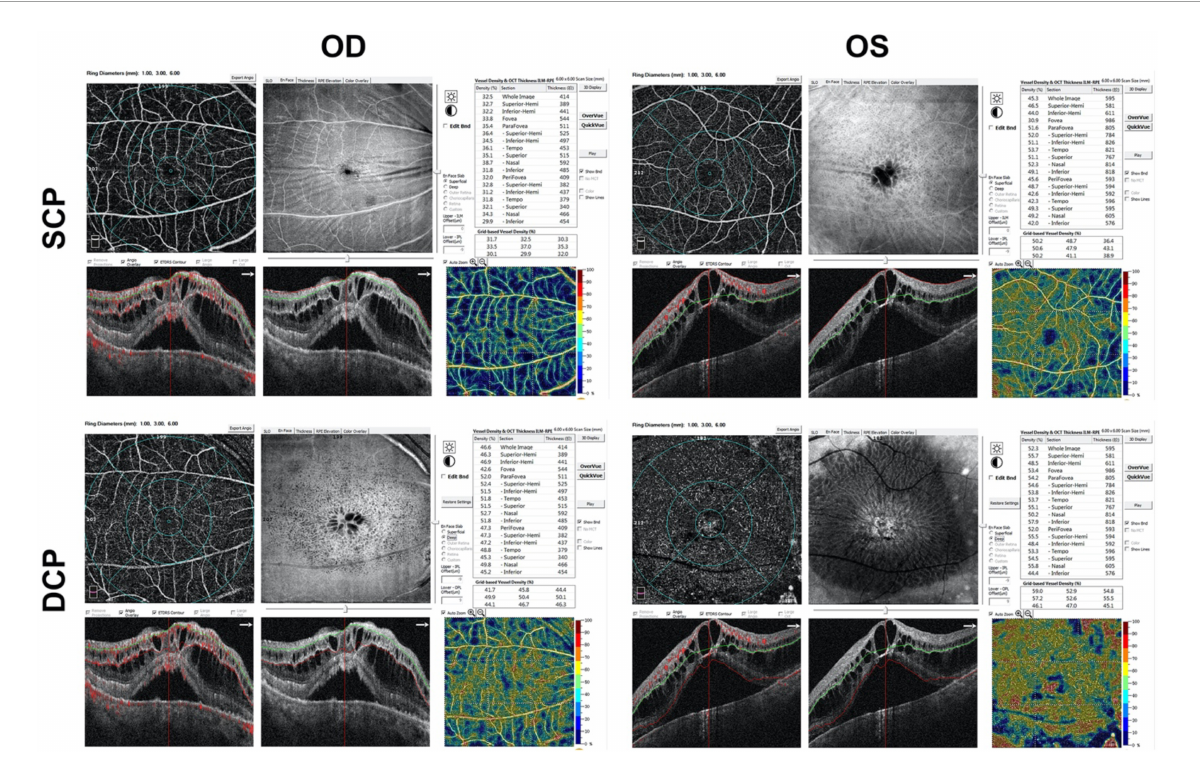
FIGURE3 Marked cystoid macular edema with intraretinal fluid, subfoveal neurosensory retinal detachment and pachychoroid on OCTA b-scan in both eyes. OD, right eye; OS, left eye; SCP, superficial capillary plexus; DCP, deep capillary